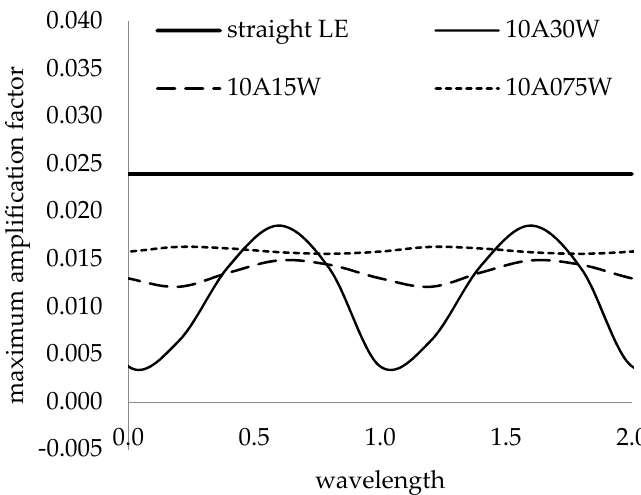
Figure 21. Global maximum amplification factor profile for fixed amplitude and variable wavelength at 0.124 chord fraction.